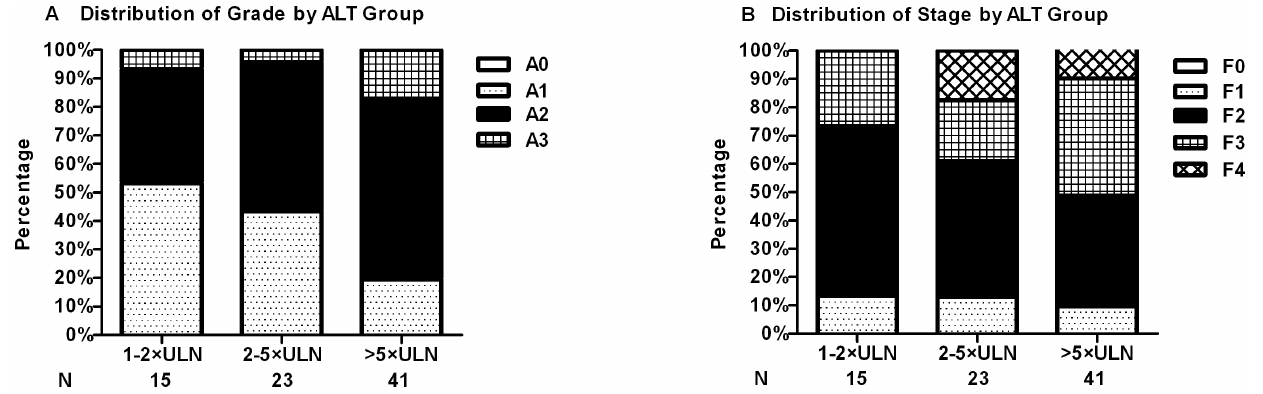
Fig. 3. Necroinflammation grade and fibrosis stage in CHD patients. (A) Necroinflammation grade in CHD patients. Significant necroinflammation ( $ A2) was found 46.7%, 56.5% and 80.5% in ALT 1–2 6 ULN, 2–5 6 ULN and . 5 6 ULN groups, respectively. Significant necroinflammation in . 5 6 ULN group were much higher than those in the 1–2 6 ULN and 2–5 6 ULN group (both P , 0.05). (B) Fibrosis stage in CHD patients. Significant fibrosis ( $ F2) was found 86.7%, 87.0% and 90.3% in ALT 1–2 6 ULN, 2–5 6 ULN and . 5 6 ULN groups, respectively. Significant fibrosis in . 5 6 ULN group were similar with those in 1–2 6 ULN and 2–5 6 ULN group (both P .